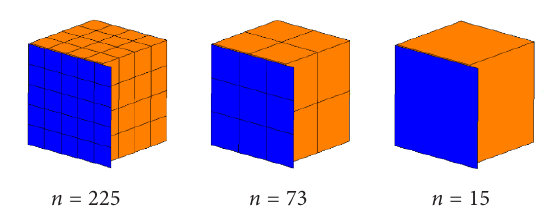
Figure 6. Varying fidelity of thermal model mesh, where n is the total number of thermal nodes. Deployable solar arrays are meshed identically as fixed array (blue), but are not shown for